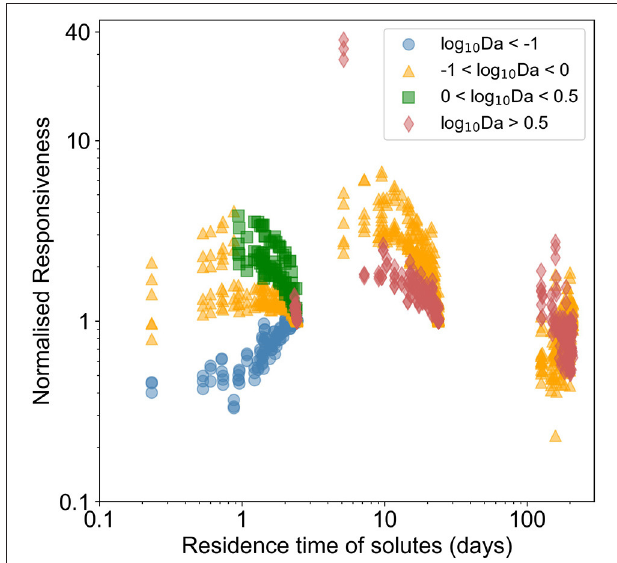
FIGURE 5 | Normalized responsiveness of chemical species leaving the domain in temporally dynamic and spatially heterogeneous domains with respect to temporally dynamic homogeneous domain. The color varies with the prevalent reaction-flow regime (red for reaction dominant regimes where log 10 Da > 0.5, green for reaction influenced regimes where, 0 < log 10 Da < 0.5, orange for transport influenced regimes with − 1 < log 10 Da < 0 and blue for transport dominated regimes with log 10 Da < − 1). Normalized responsiveness close to 1 indicates that the temporal dynamics induced in a spatially heterogeneous domain is similar to those induced in the corresponding homogeneous domain.